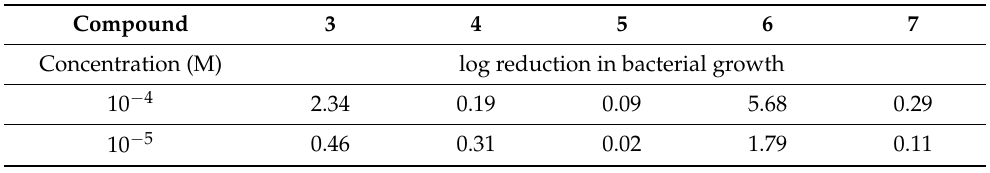
Table 3. Photodynamic activity of the studied phthalocyanines against Staphylococcus aureus upon excitation with red light at the dose of 30 J/cm 2 .